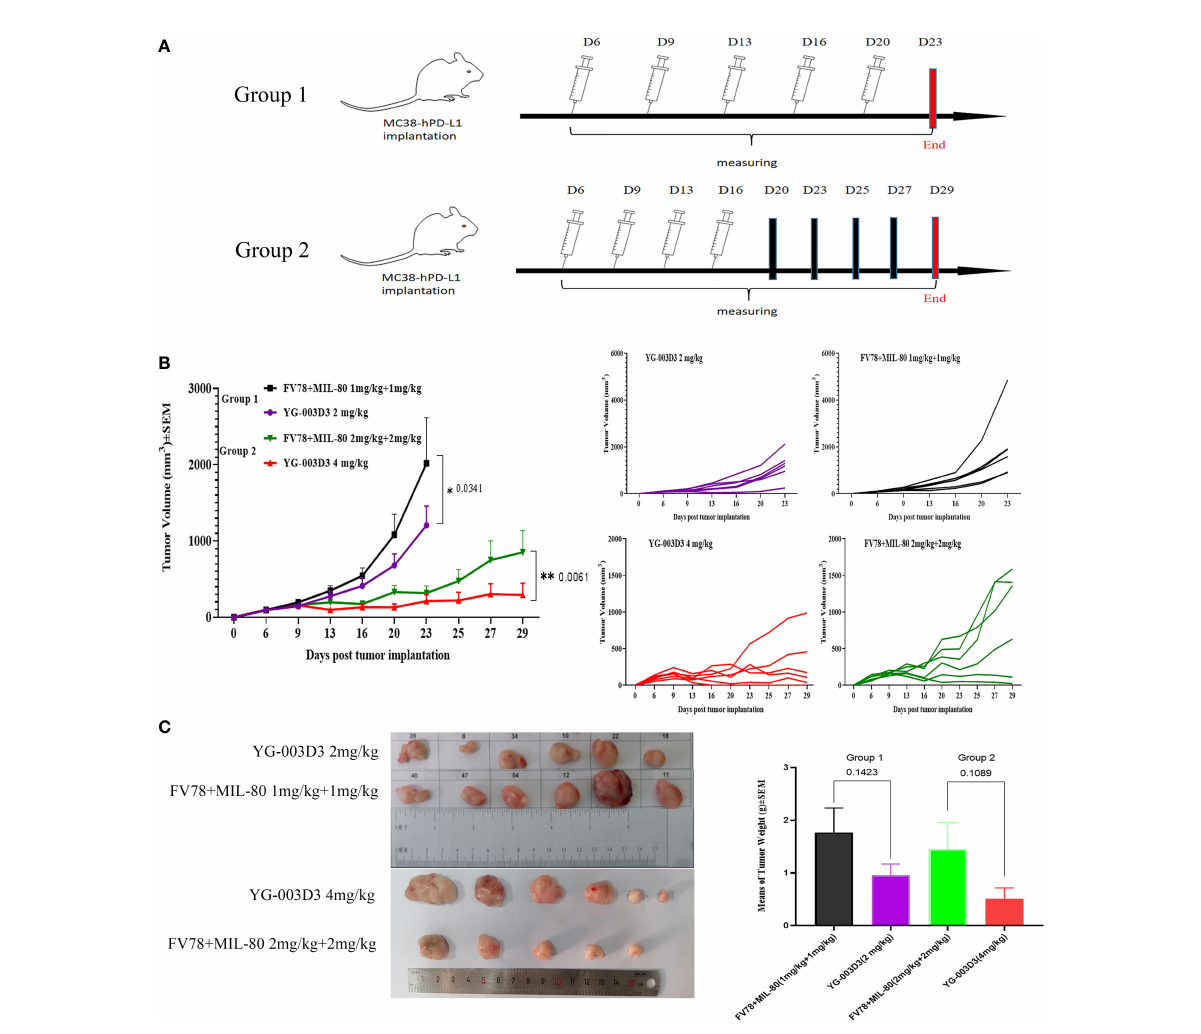
FIGURE 6 Comparison of antitumor effect between YG-003D3 and combination group. (A) The schedule in human PD-1/LAG-3 double knock-in mice bearing MC38(hPD-L1) were treated with antibodies (n=6 mice/group). (B) Tumor growth trend chart in human PD-1/LAG-3 double knock-in mice bearing MC38(hPD-L1) were treated with antibodies. (C) At the end of the experiment, animals were euthanized, and tumor blocks were stripped and weighed. Dates were considered statistically signi fi cant when p values lower than 0.05 (*p <0.05, **p <